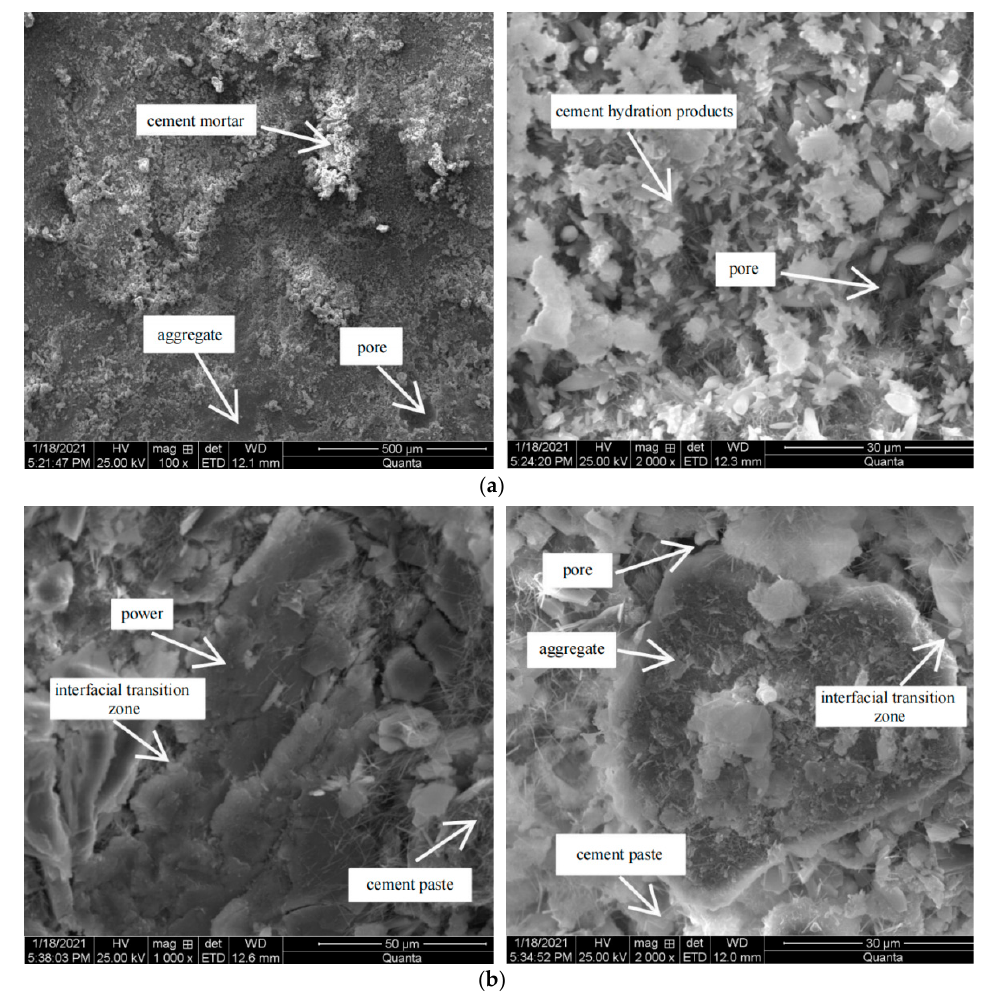
Figure 20. SEM images of R 0 C 0 ( a ) and R 0.5 C 0 ( b ) specimens.